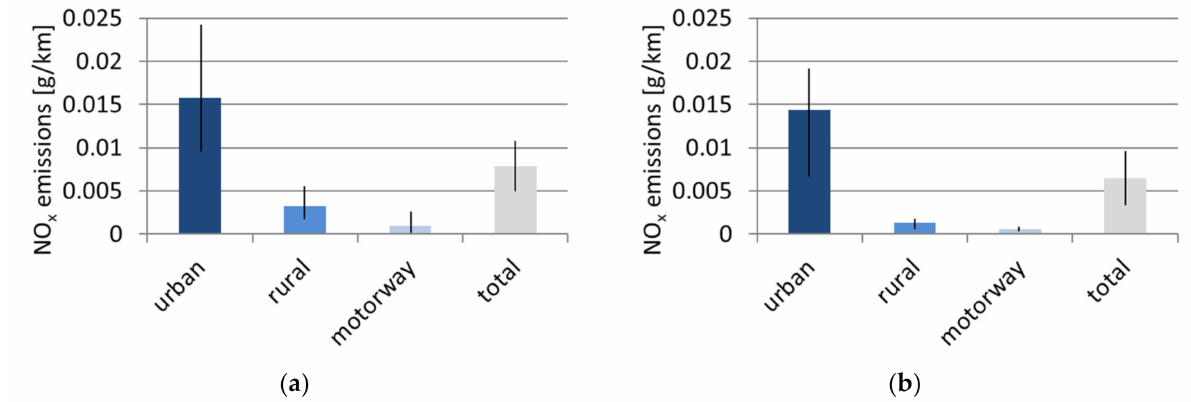
Figure 12. Seasonal influence of driving mode on the real-world NO x emissions of the studied PHEV considering hybrid driving mode. ( a ) Summer time; ( b ) autumn